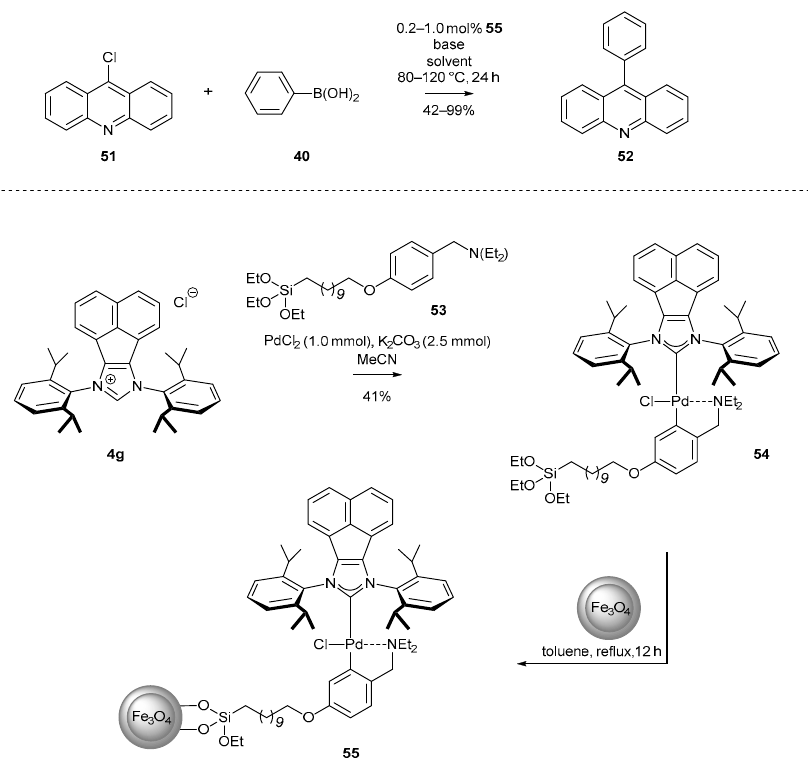
Scheme 24. Immobilization of palladium complexes on magnetic nanoparticles and their application in the Suzuki-Miyaura coupling of